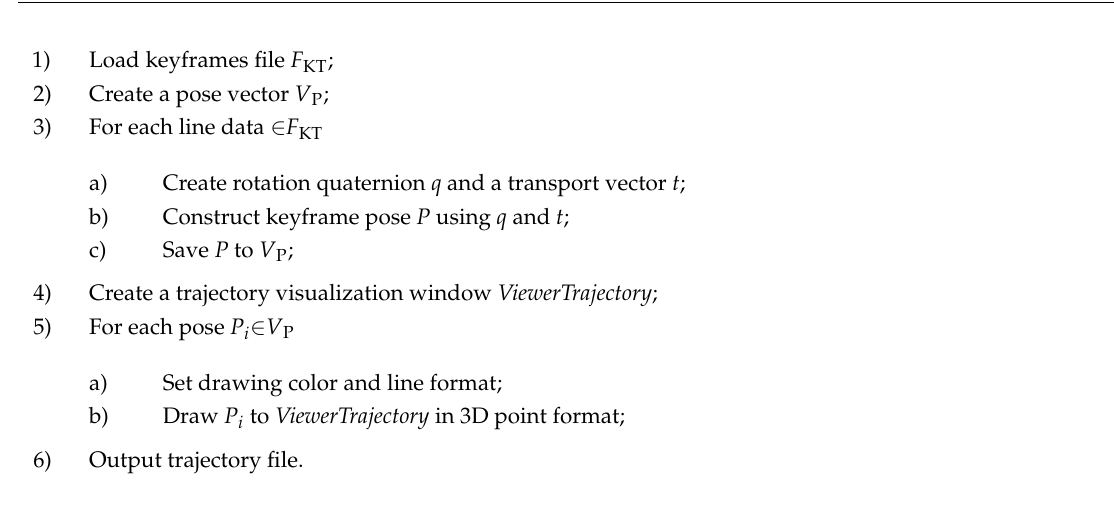
Algorithm 6: Offline visualization method of mapping